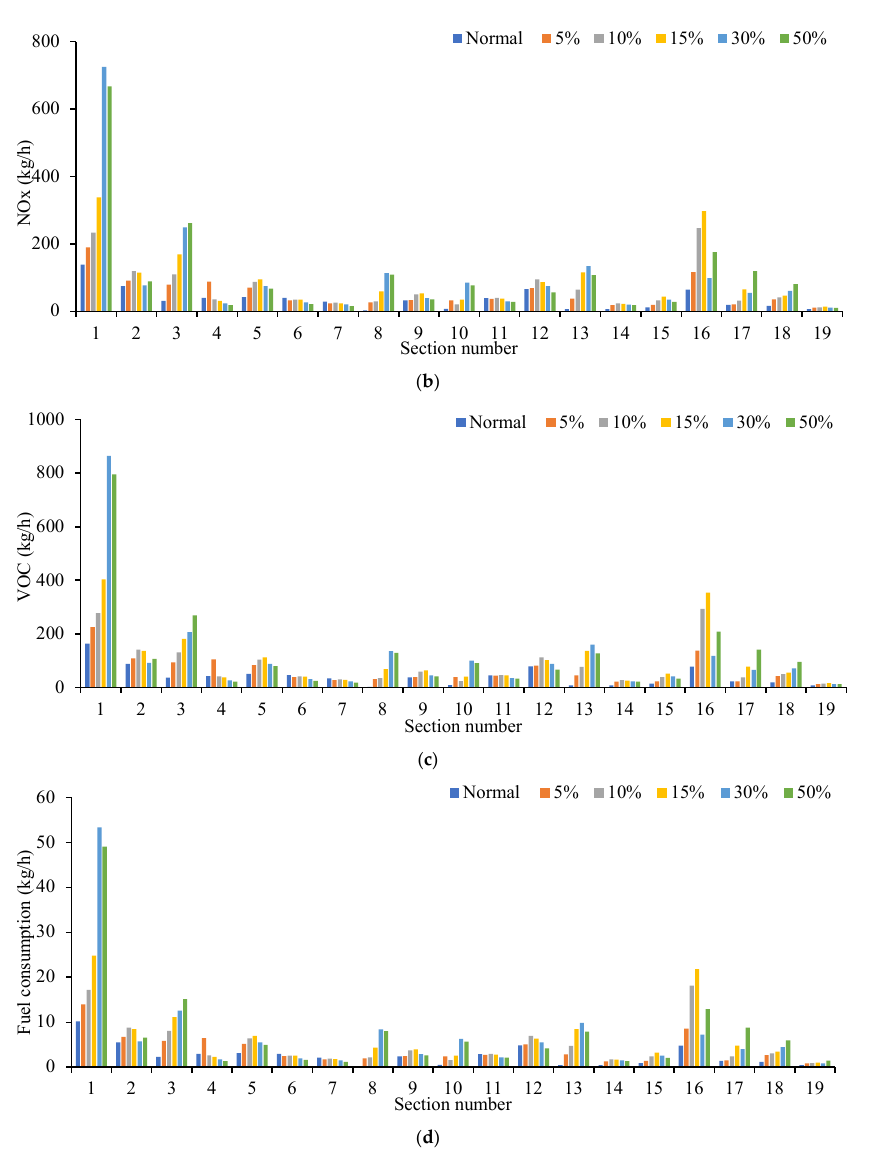
Figure 20. Comparison of four indicators at different sections. ( a ) Comparison of CO emission under different sections. ( b ) Comparison of NO X emission under different sections. ( c ) Comparison of VOC emission under different sections. ( d ) Comparison of fuel consumption under different sections.